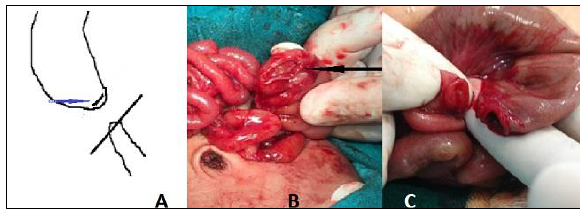
Figure:1 A) Line diagram showing the level of incision which was perpendicular to the gut and involved summit of the distal end of proximal dilated segment (solid blue arrow pointing the incision line in proximal segment). B) Proximal segment after incision (shown by black arrow). C) Proximal and distal end after incision.